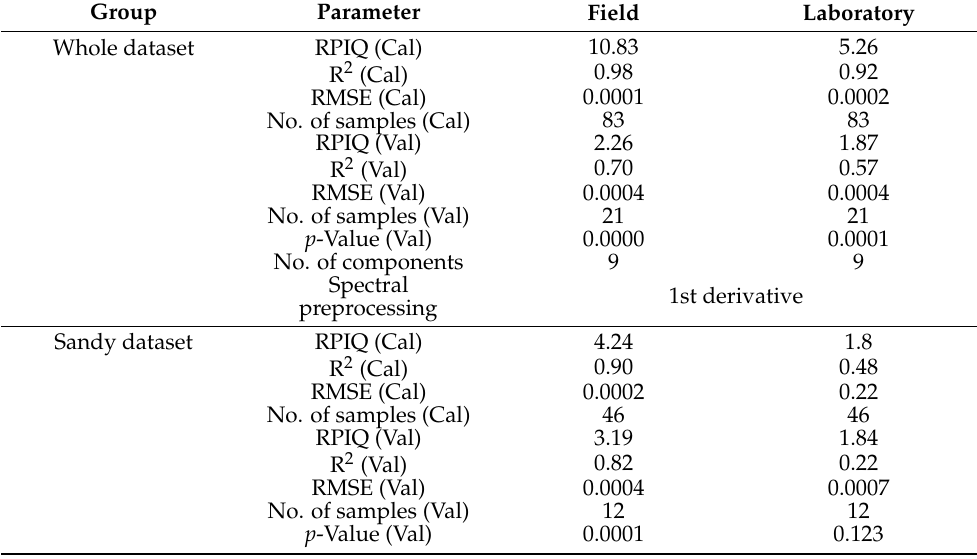
Table 4. Statistical parameters of the spectral-based models before spectral resampling (450–2400